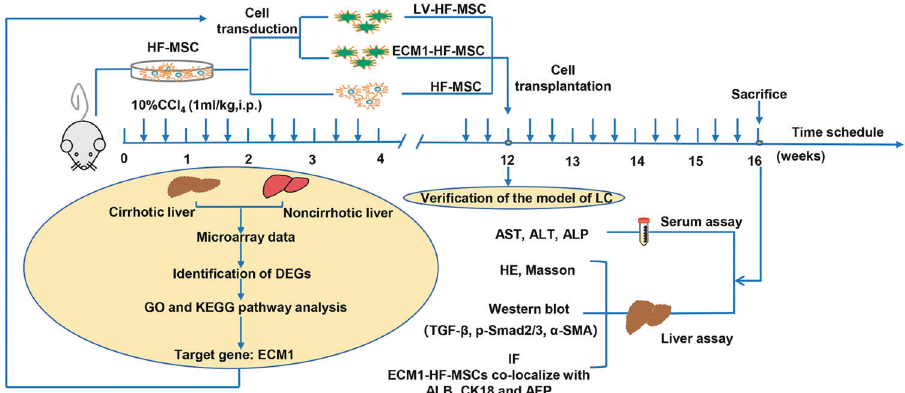
Fig. 1 Overview of the experimental design. The DEGs related to LC were analyzed using bioinformatic tools. ECM1 was selected from the DEGs and was then used to modify HF-MSCs. The cells were injected into mice with CCl 4 -induced LC through the tail vein. Four weeks after cell transplantation, serum and liver tissue were collected for HE and Masson staining and Western blotting and immuno fl uorescence